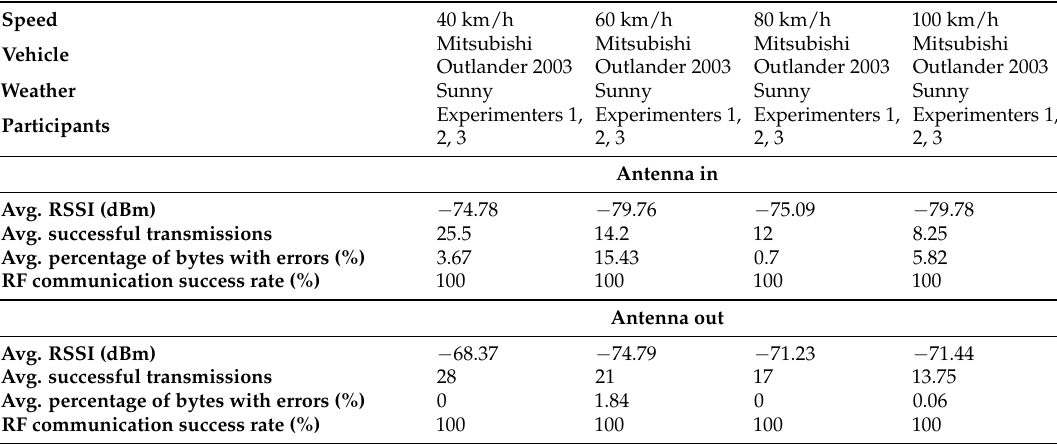
Table 4 summarizes the results of the data stored in the MOVI-STOP module during the field tests. Table 4. MOVI-BUS–MOVI STOP field test